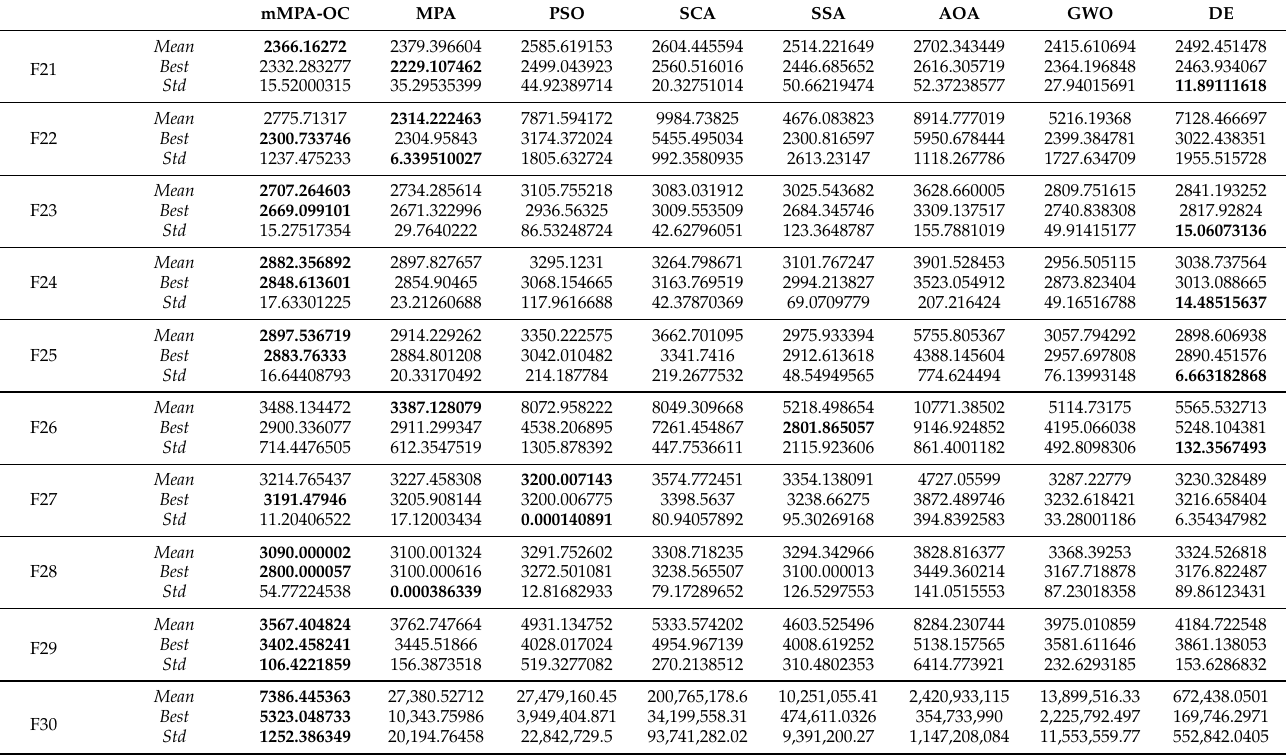
Table 12. Comparison of experimental results on CEC-2017 (30-dimensional) combinatorial